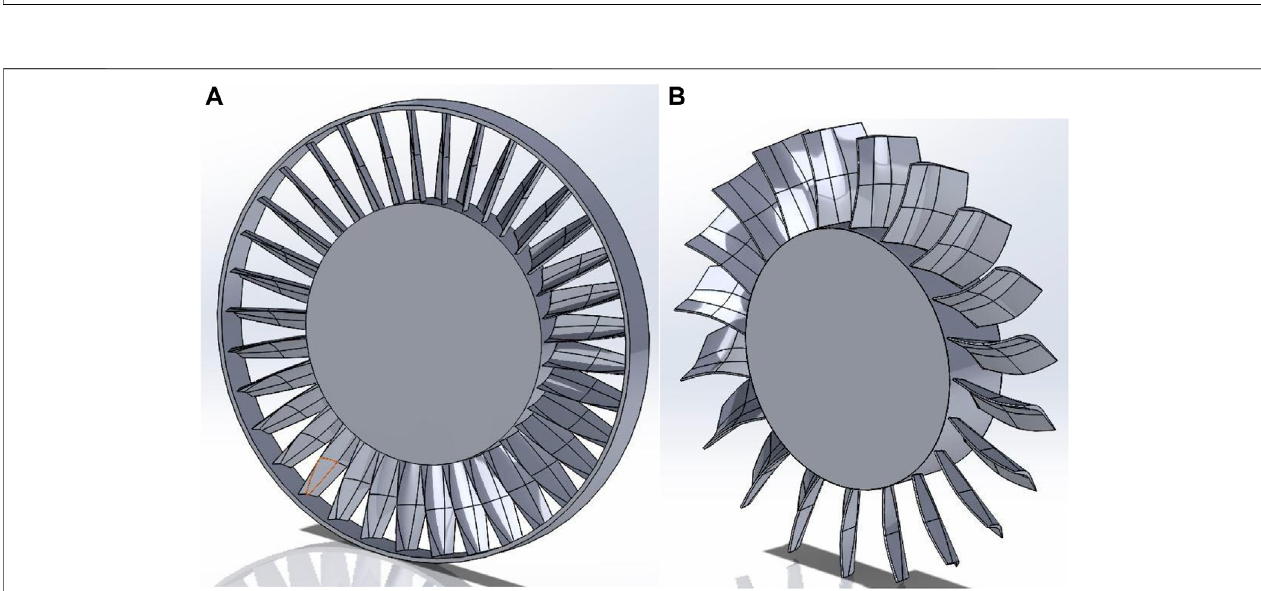
FIGURE 9 | Stator (A) and rotor (B)